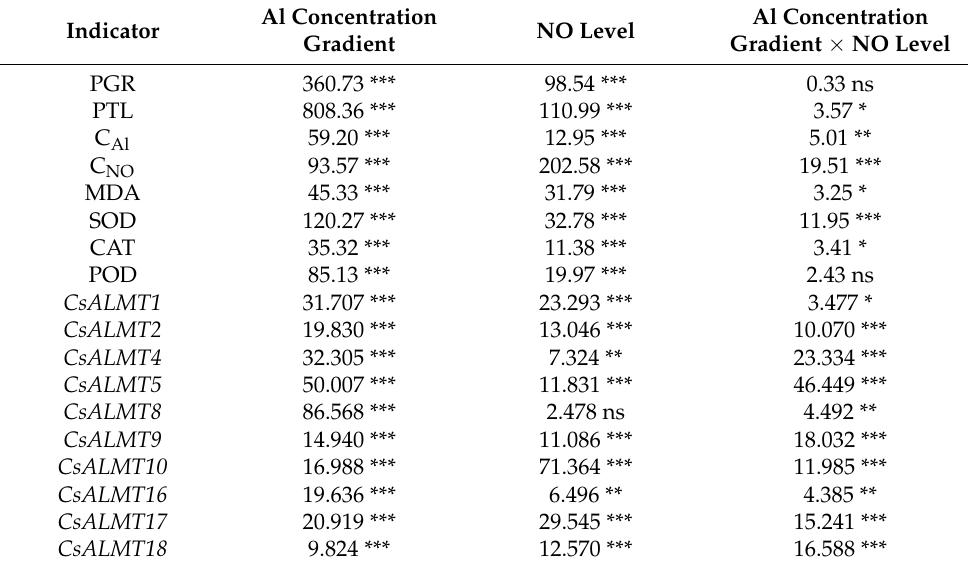
Table 1. Two-way ANOVA test F value of pollen germination rates (PGRs), pollen tube lengths (PTLs), cytoplasmic Al 3+ (C Al ) and NO (C NO )concentrations, malondialdehyde (MDA) contents, antioxidant enzyme activities and relative expression level of CsALMTs for C. sinensis cv ‘Longjing43’ affected by Al concentration gradient and NO level in the culture